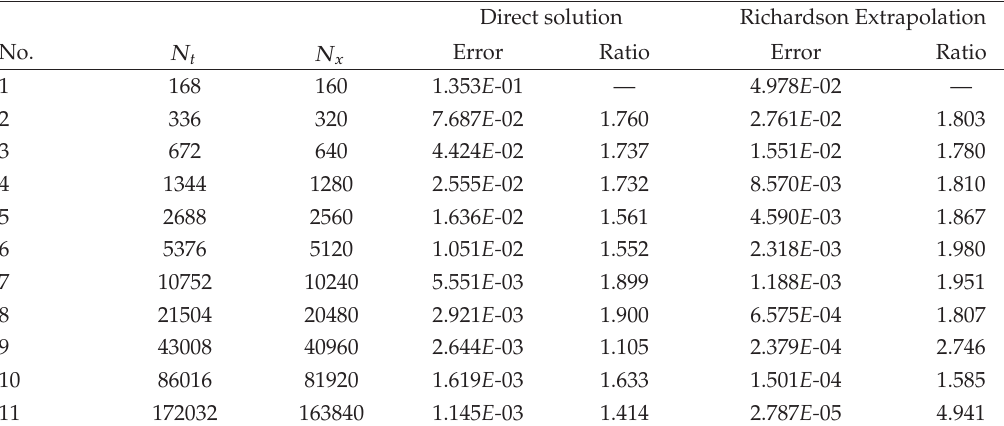
Table 3: Results obtained when the test problem defined in Section 5.4 is handled directly by the Crank- Nicolson scheme and by using the combination of the Crank-Nicolson scheme and the Richardson Extrapolation. The numerical errors calculated by (cid:6) 5.1 (cid:7) and (cid:6) 5.2 (cid:7) are given in the columns under “Error”. In row s, s (cid:3) 2 , 3 ,..., 11, the ratios of the errors in this row and in the previous row are given in the columns under “Ratio”. Direct solution Richardson Extrapolation